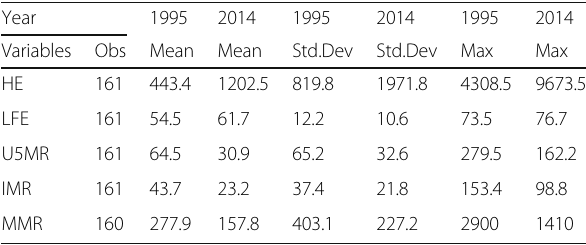
Table 1 Summary statistics